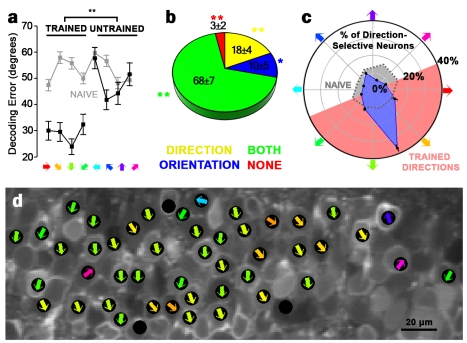
Training-induced changes are stimulus-specific.(a) Decoding error for each direction in tadpoles trained with four of eight stimuli (0–135°), using the correlation decoder. Gray, decoding error of naive control tadpoles. Training-induced decoding improvement is specific to the trained stimuli. (b) Proportion of neurons showing direction (yellow), orientation (blue), both (green), or neither (red) selectivity in tadpoles trained with four stimuli. Asterisks denote significant difference from corresponding proportion in naive control tadpoles. (c) Angle histogram of preferred directions of direction-selective neurons in tadpoles trained with four stimuli. Points are the proportion of neurons with center directions falling between adjacent stimulus directions. Pink shading indicates the trained directions. Responses strongly favored the center of the trained directions (one-sample t-test, p<10−5). Gray dotted line indicates preferred directions in naive control tadpoles. (d) Map of direction selectivity in a tadpole after training with four stimuli. Black circles mark neurons showing significant direction selectivity. Colored arrows mark preferred directions. Error bars denote SEM. (a–c) n = 3 tadpoles (152 neurons). *p<0.05; **p<0.01.